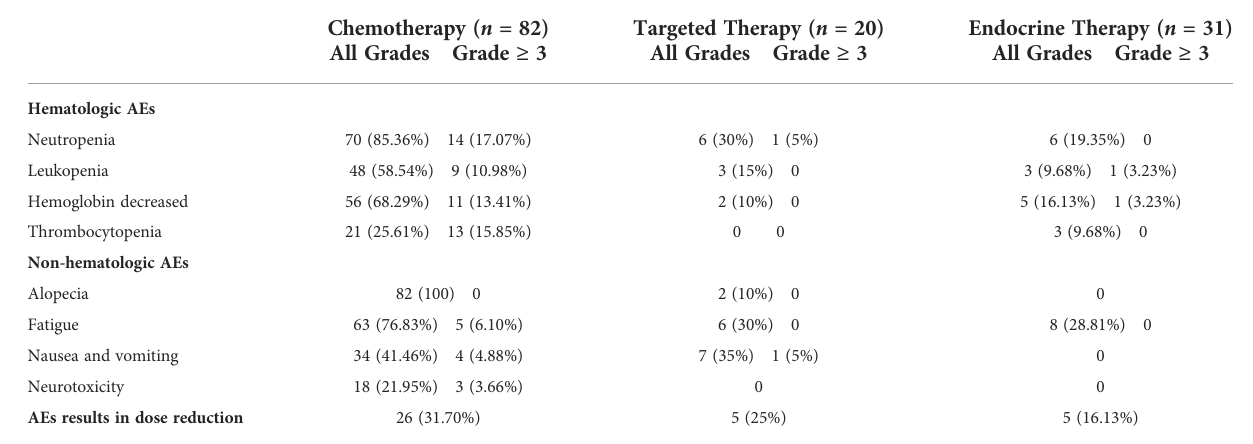
TABLE 3 AEs after